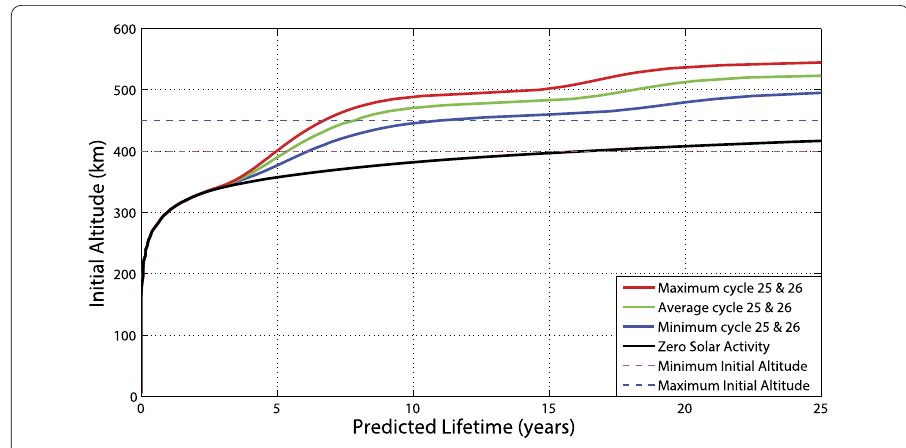
Figure 6 Deorbit analysis for a 10 kg 6U CubeSat in minimum drag configuration. As atmospheric drag depends strongly on solar activity and consequent atmospheric expansion, we calculate orbital lifetimes for consecutive minimum (very low intensity, solar max of 140SFU), average (moderate intensity, solar max of 190SFU) or maximum (high intensity, solar max of 230SFU) solar cycles following the current solar cycle. An extended period of no solar activity, much like the Maunder Minimum event, is included for completeness. The representative solar cycles used herein were derived from historical solar cycle data. The ISS orbit varies and is periodically reboosted with orbit raising manoeuvres to combat orbital decay, the range of altitudes is indicated by the dashed horizontal lines and is derived from the standard operating altitudes of the ISS